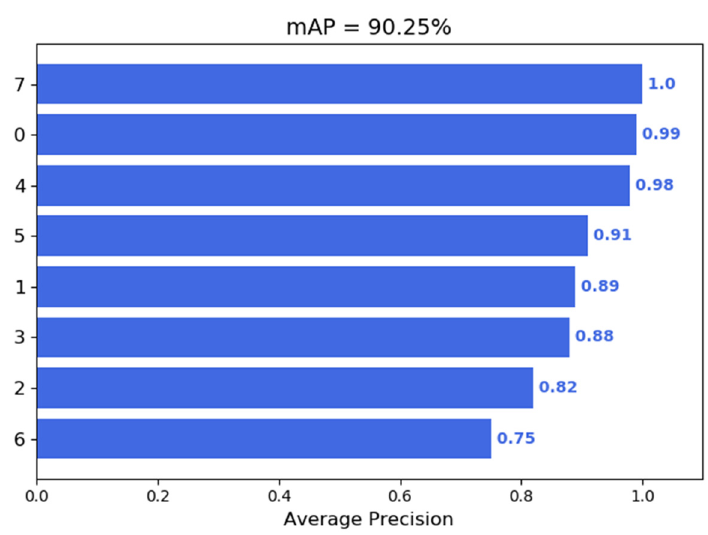
Figure 13. Training set evaluation results.